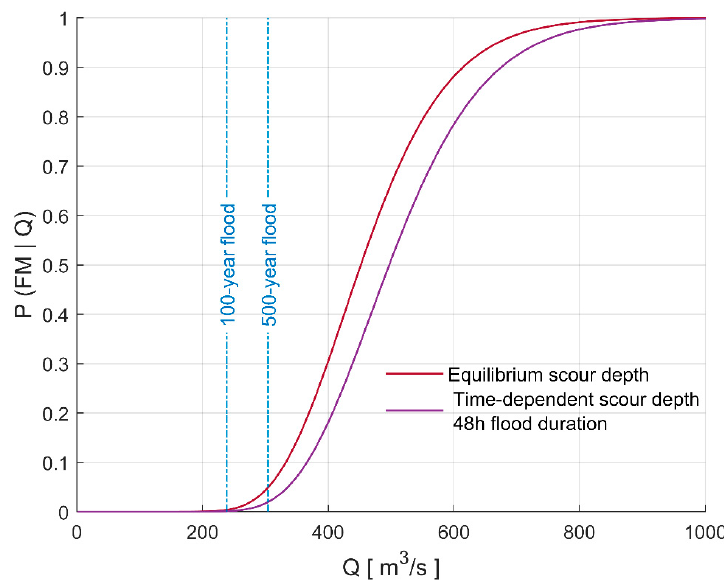
Figure 7. Flood fragility function for the MAB under